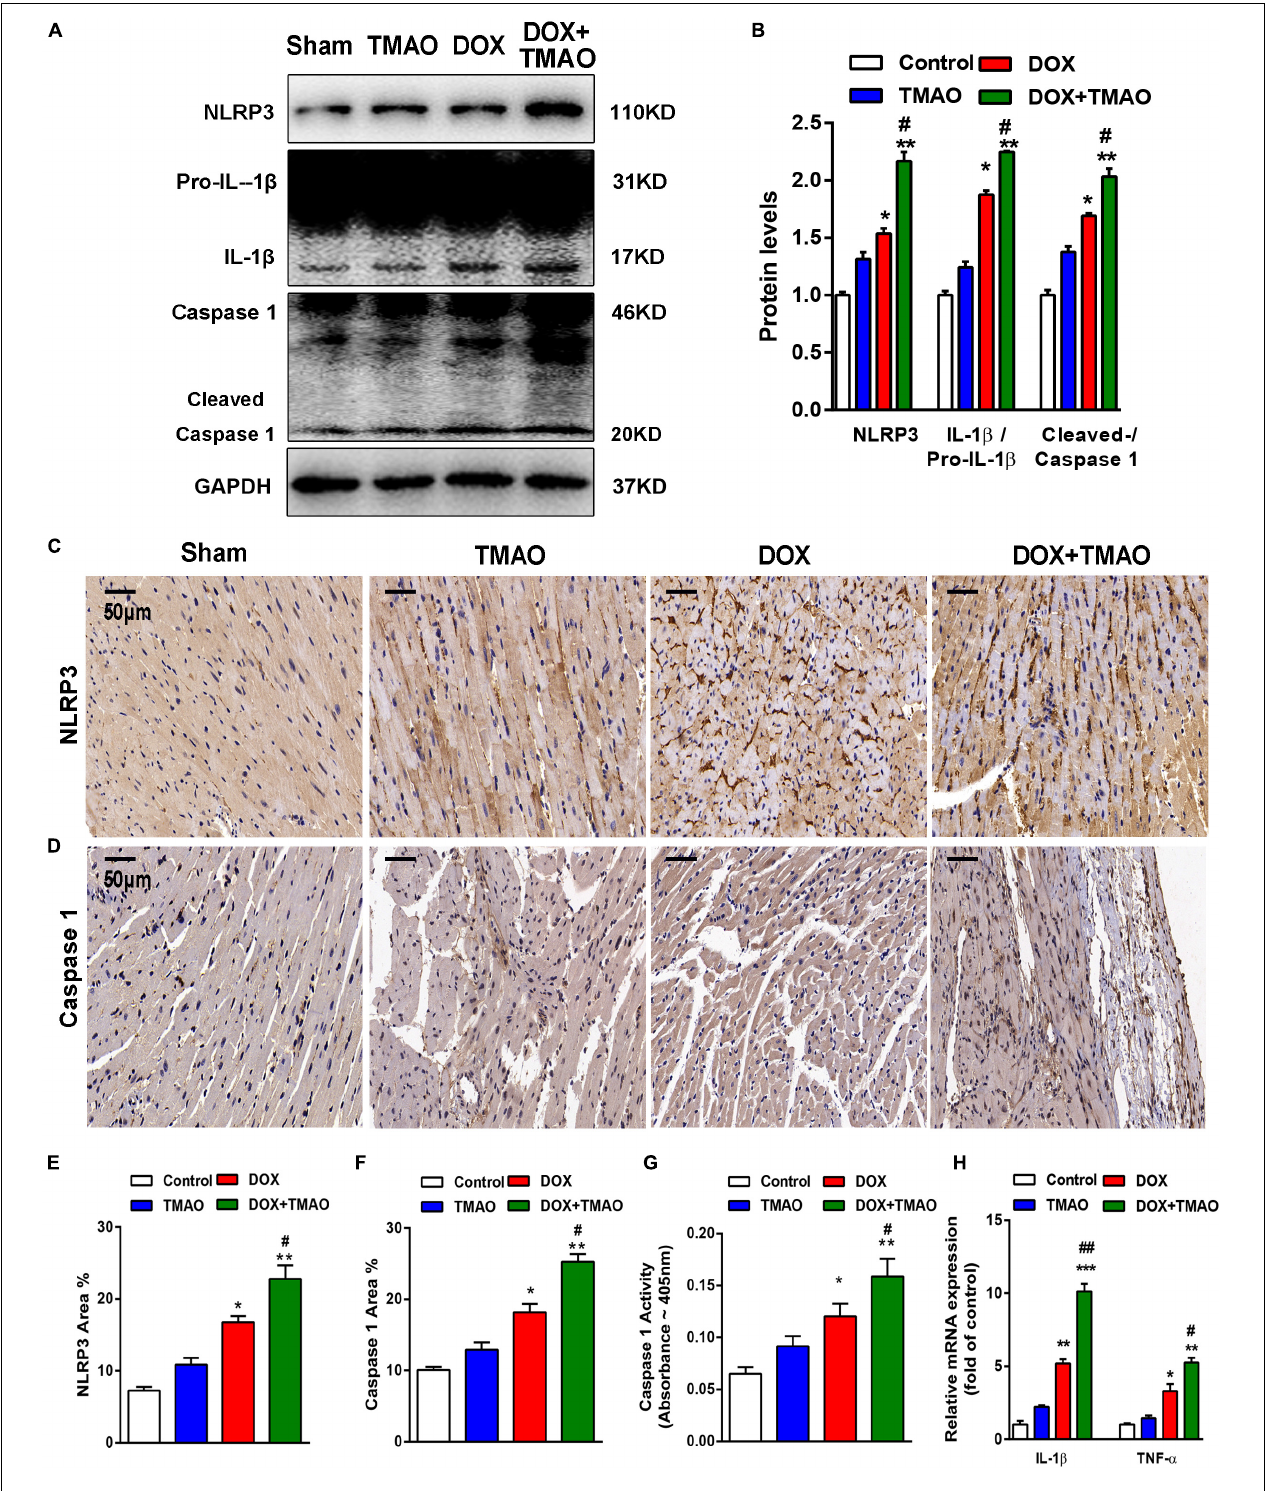
FIGURE 4 | TMAO induced NLRP3 inflammasome activation in vivo . (A) NLRP3, pro-IL-1 β , IL-1 β , caspase 1 and cleaved caspase 1 protein expression was analyzed by western blotting and quantified (B) according to immunoblotting (the ratio of protein pixel density/GAPDH pixel density) after 8 weeks. (C) Representative images of immunohistochemical staining for NLRP3 and caspase 1 (D) in cardiac sections. Scale bar = 50 µ m. (E) Quantification of the percentage of NLRP3- and caspase 1-positive areas (F) . (G) Caspase-1 activity was determined by caspase-1 activity assay. (H) QRT-PCR analysis of TNF- α and IL-1 β mRNA expression levels in heart tissues. All data were analyzed at least three times. Mean ± SD. ∗ P < 0.05, ∗∗ P < 0.01, ∗∗∗ P < 0.001 (vs. Control). # P < 0.05, ## P < 0.01 (vs. DOX).